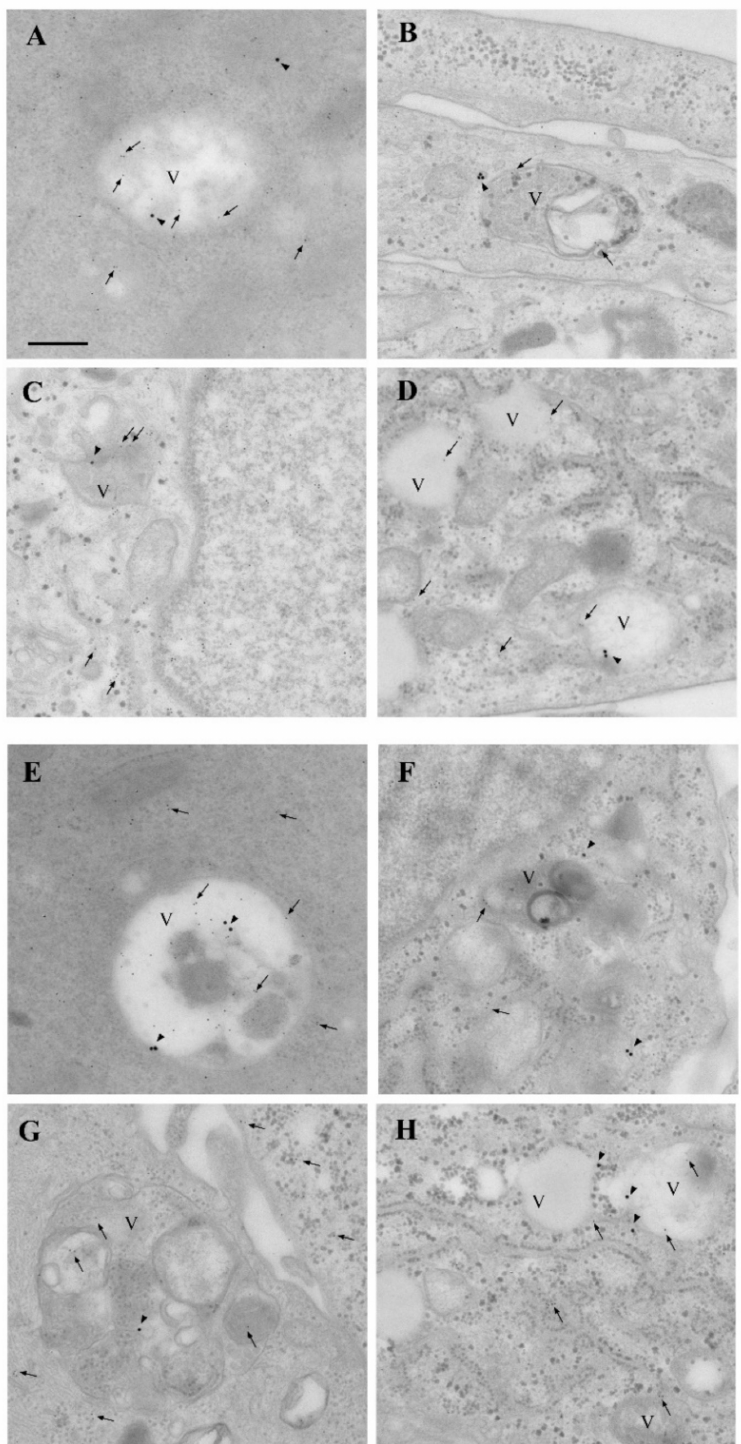
Figure 14. Rapamycin-induced α -syn + LC3- and α -syn + cathepsin D-positive vacuoles in GBM cells. Representative micrographs showing astrocytes ( A , E ) and U87MG cells ( B , F ), in baseline conditions and following rapamycin exposure at 10 nM ( C , G ) and 100 nM ( D , H ). Immuno-gold for α -syn (20 nm) and LC3 (10 nm) is shown in ( A – D ), while immuno-gold for α -syn (20 nm) and cathepsin D (10 nm) is shown in ( E – H ). Arrowheads = α -syn immuno-gold particles; arrows = LC3 or cathepsin D immuno-gold particles. V = vacuole. Scale bar = 0.15 µ